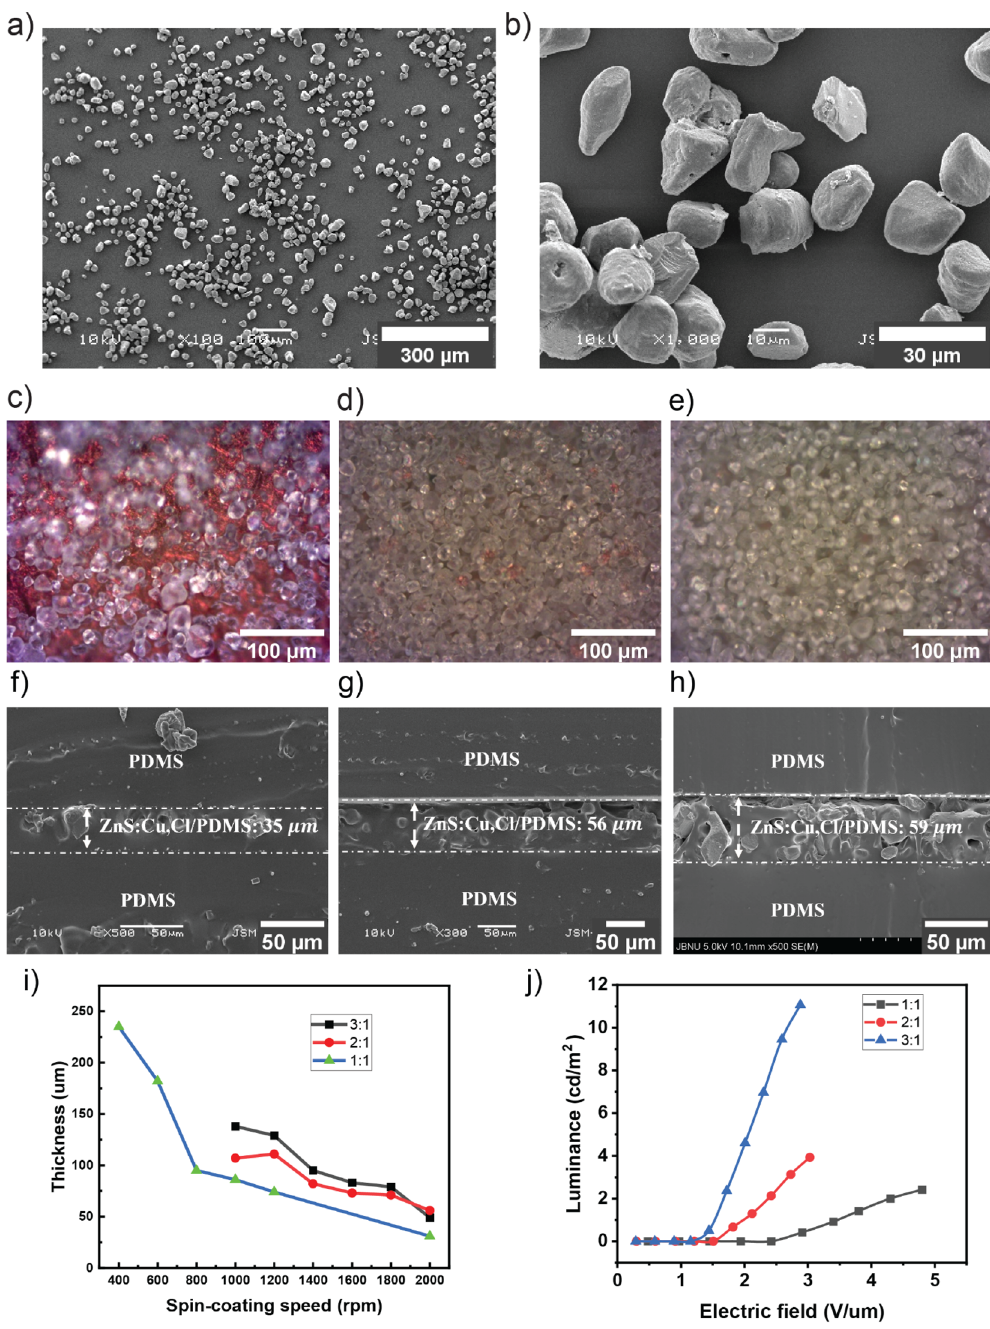
Figure 4. ( a , b ) FE-SEM of ZnS:Cu,Cl particles with different magnifications. ( c – e ) Optical microscopy images of ZnS:Cu,Cl particles coated on Cu NW-based electrode; the weight ratio of ZnS:Cu,Cl/PDMS was 1:1, 2:1, and 3:1 in ( c – e ), respectively. ( f – h ) cross-sectional SEM images of fabricated EL devices with the corresponding weight ratio of ZnS:Cu,Cl/PDMS. ( i ) Thickness of emissive layer prepared with the different weight ratios of ZnS:Cu,Cl/PDMS and spin-coating speed. ( j ) The luminance of EL devices prepared with the different weight ratios of